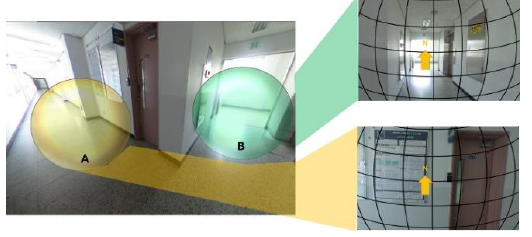
Figure 4. Consistency of Image Headings